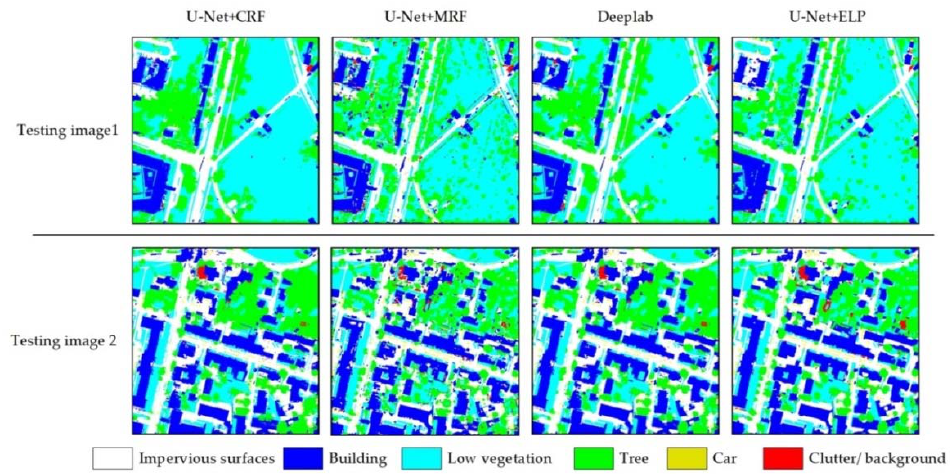
Figure 11. Results of the four methods.